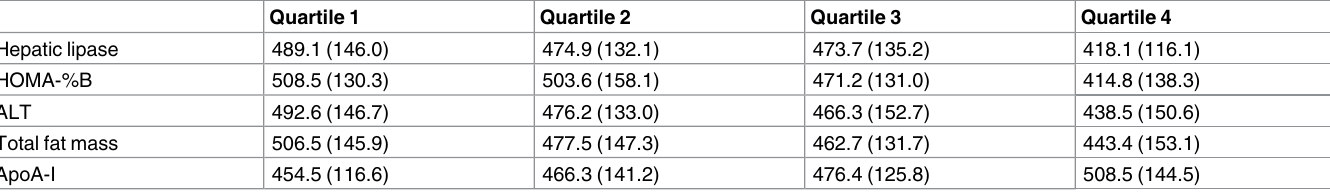
Table 4. Median MCRI values by quartile of significant traits from the overall multivariate